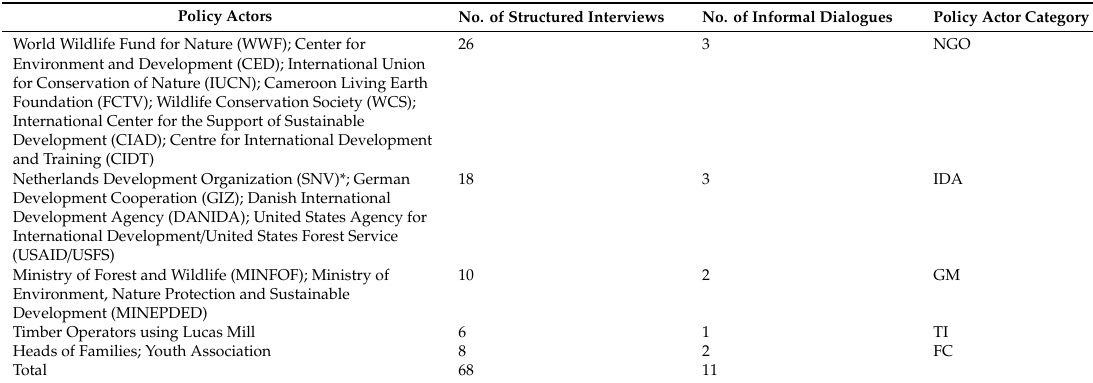
Table 1. Number of interviews and informal dialogues with policy actors. No. of Structured